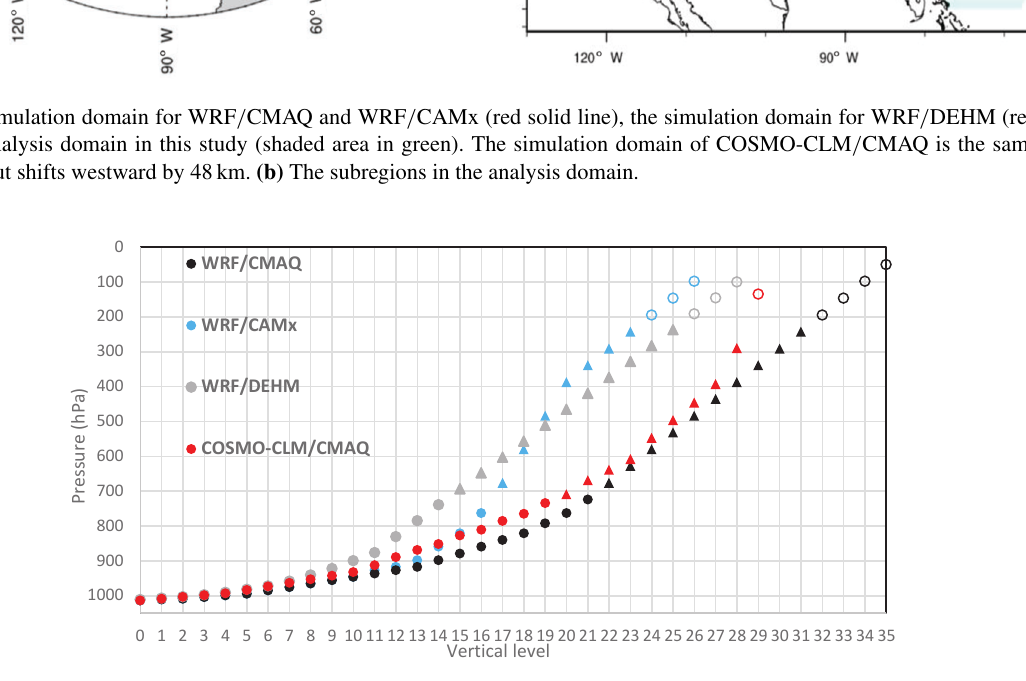
Figure 2. Vertical grid structures for the chemical transport models used in the four simulations, with filled circles for the vertical levels for BC1, filled triangles for BC2, and open circles for